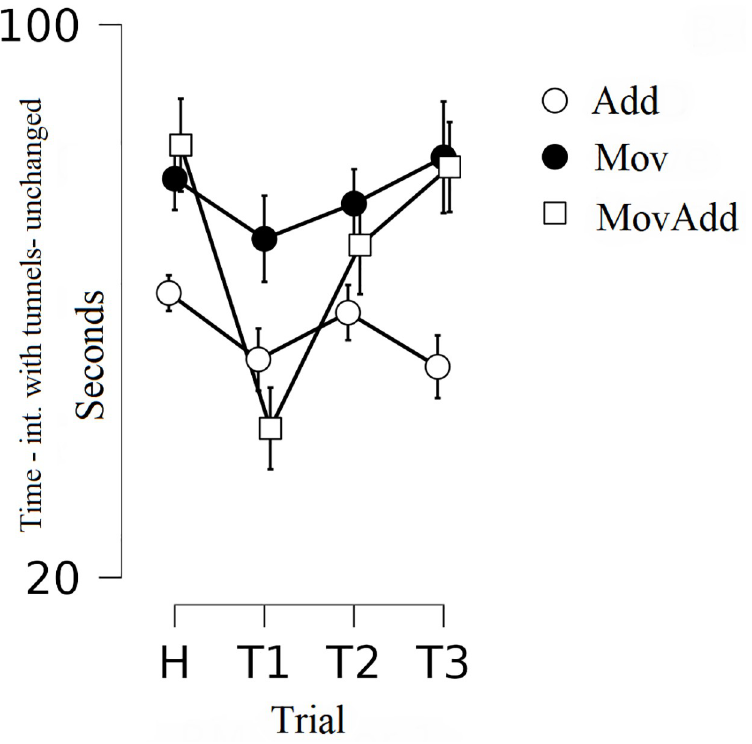
Fig 5. Mean time spent on contact with the tunnels in the unchanged zone of the chamber. Group Add: addition of novel stationary objects in the experimental box, group Mov: movement of familiar objects in the experimental box, group MovAdd: addition of a novel movable object in the experimental box. Error bars represent standard error (SE).